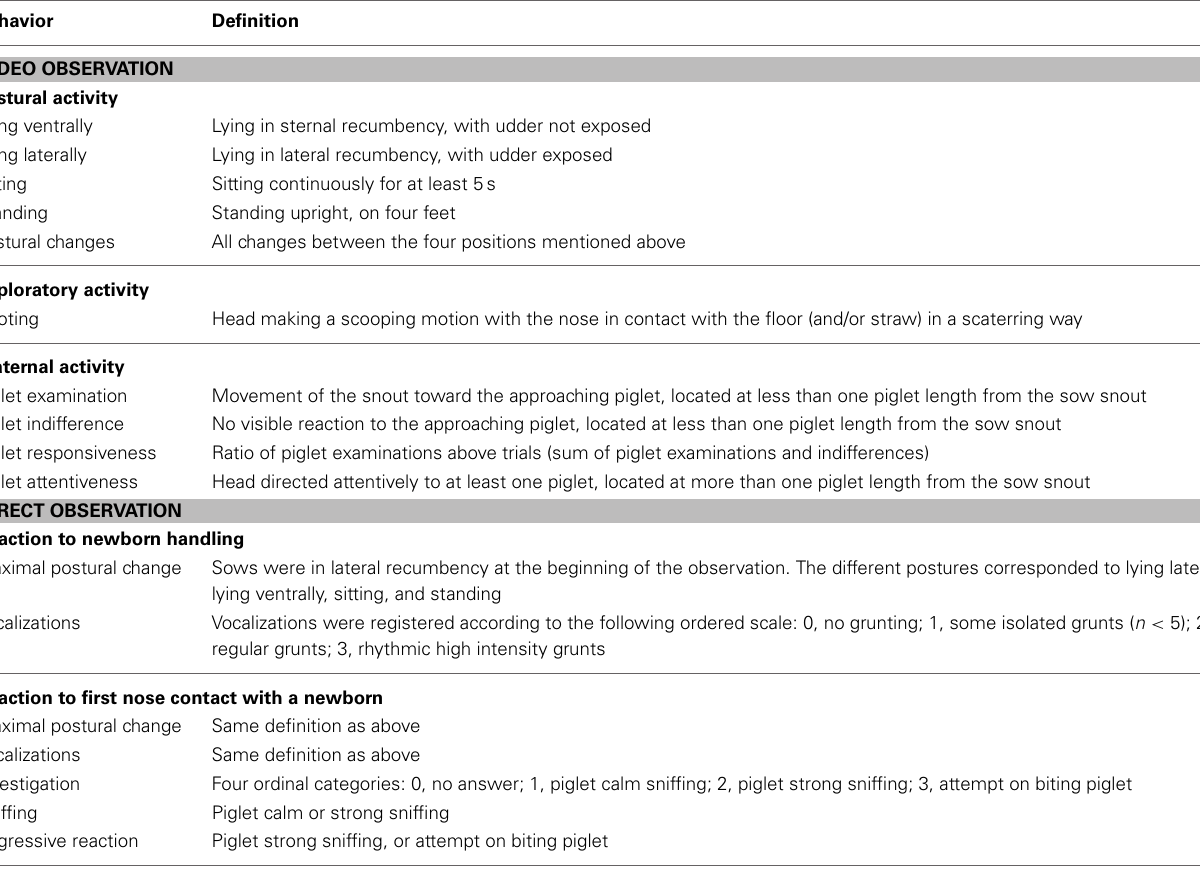
Table 1 | Behavioral measurements for the comparison of old-type sows and modern-type sows.